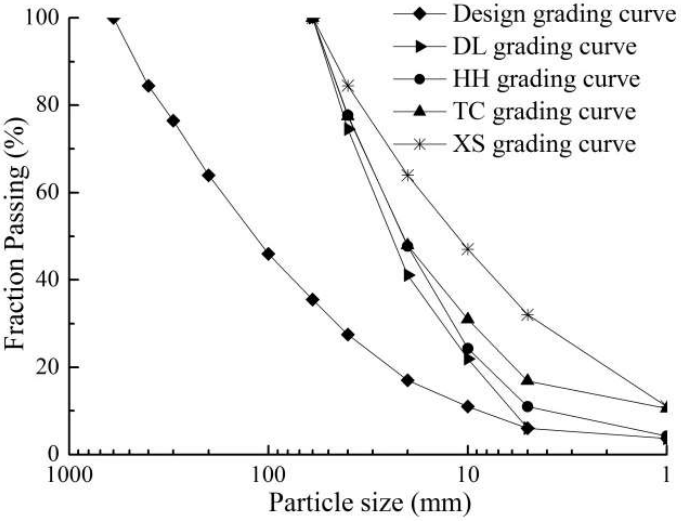
Figure 1. Grading curves.